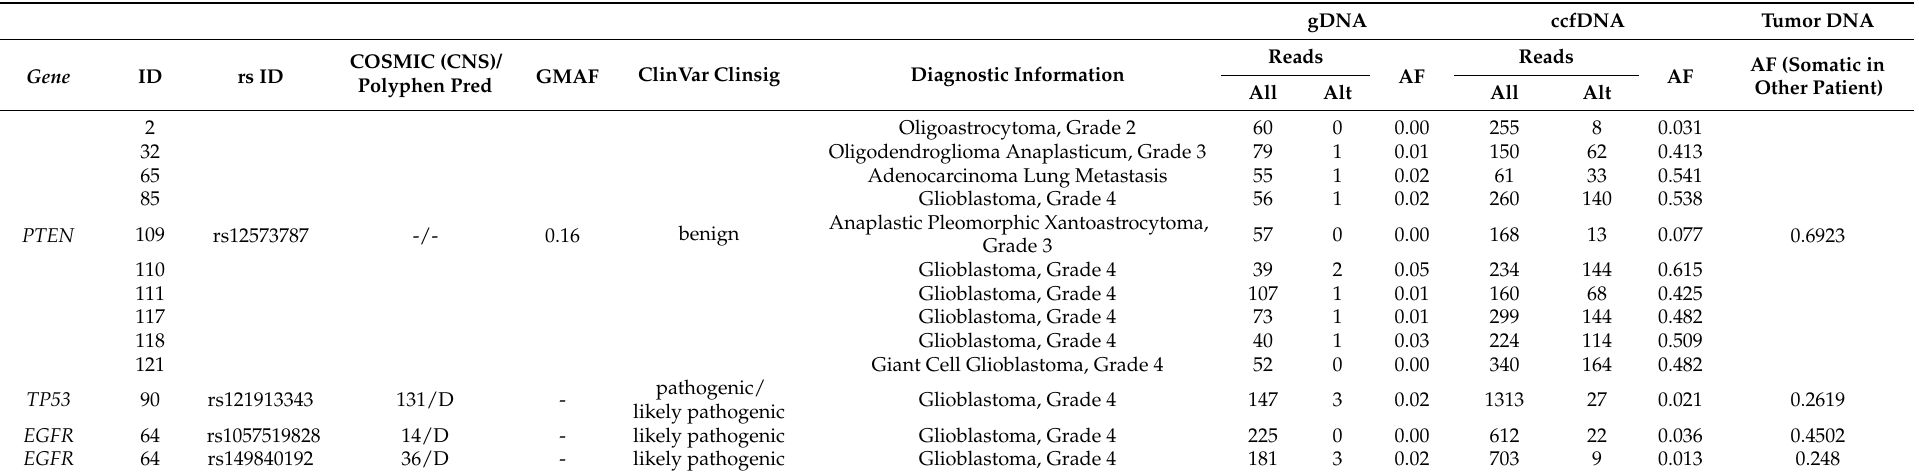
Table 3. Variants detected in ccfDNA, but not present in gDNA, confirmed as somatic in previous studies, tumor alterations.